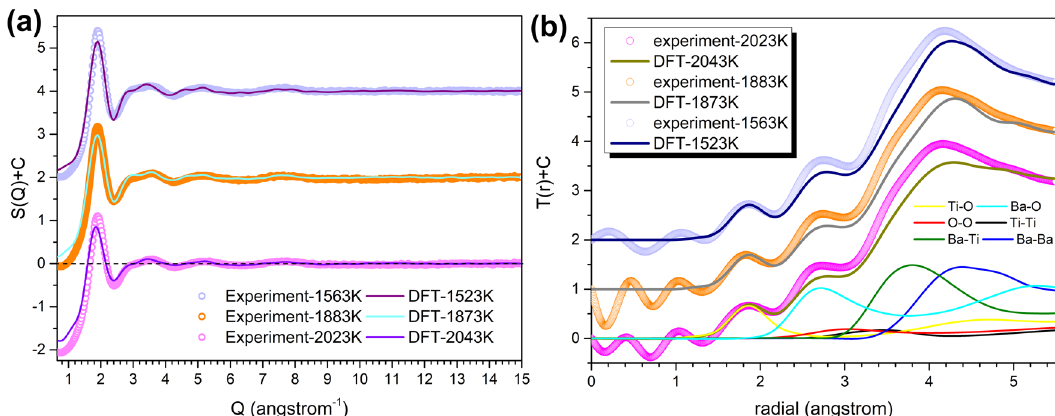
Fig. 5 The comparison of structural correlation functions determined by AIMD simulation and experimental measurement. a Faber – Ziman structural factors, S ( Q ); b total distribution functions, T ( r ). In order to manifest the contribution of each partial atomic pairs on total scattering, the partial T ij ( r ) functions corrected by real-space X-ray weighting factors, W ij ð r Þ (cid:3) T ij ð r Þ , are also presented in b . Note that the W ij ð r Þ is the Fourier transform of W ij ð Q Þ , and (cid:3) represents convolution operation.